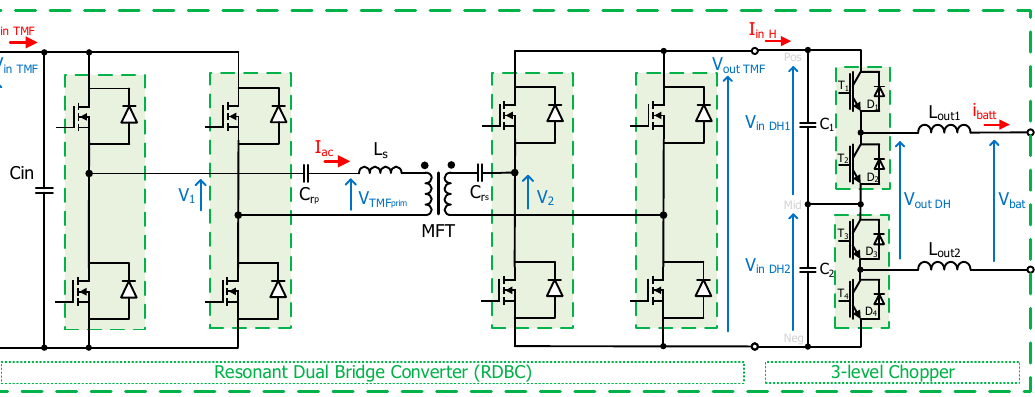
Figure 2. Isolated DC/DC converter: principle of an elementary block of the current prototype.